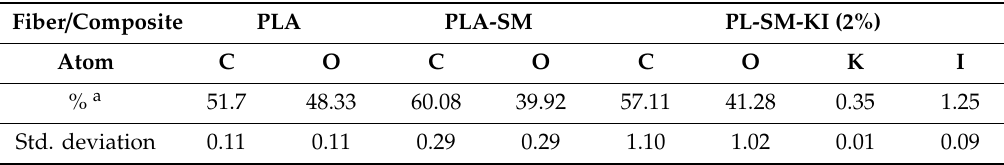
Table 3. Results of the Energy-Dispersive X-ray Spectroscopy (EDS) analysis of PLA, PLA